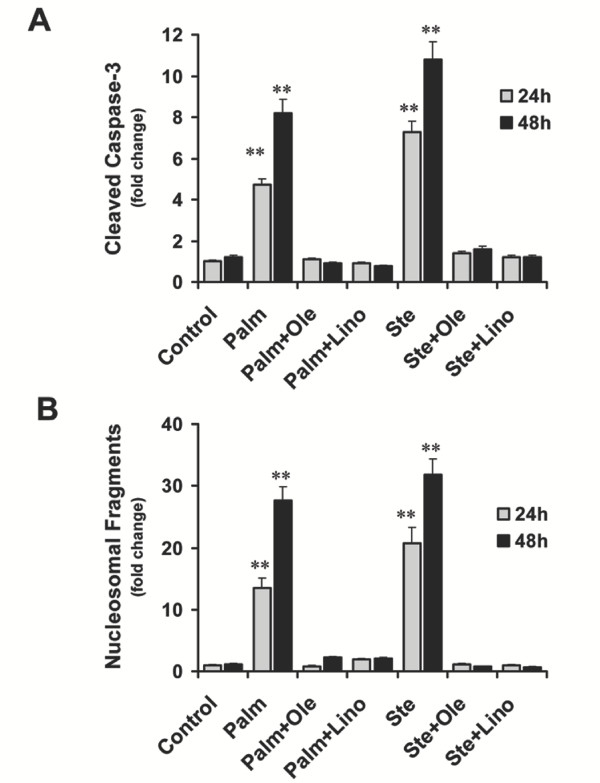
Unsaturated FFA block apoptosis induced by saturated FFA. HMC were incubated for 24 or 48 h with 0.2 mM palmitate (Palm) or stearate (Ste) alone or in co-incubations with 0.2 mM of the unsaturated FFA oleate (Ole) or linoleate (Lin). Control cells were incubated with albumin alone. After 24 and 48 h, the level of (A) the cleaved fragment of caspase-3 and (B) cytoplasmic nucleosomal fragments were determined by ELISA and expressed relative to the 24 h control value. Data are mean ± SEM for n = 3 independent experiments in triplicate. **, P < 0.01 by ANOVA versus control.